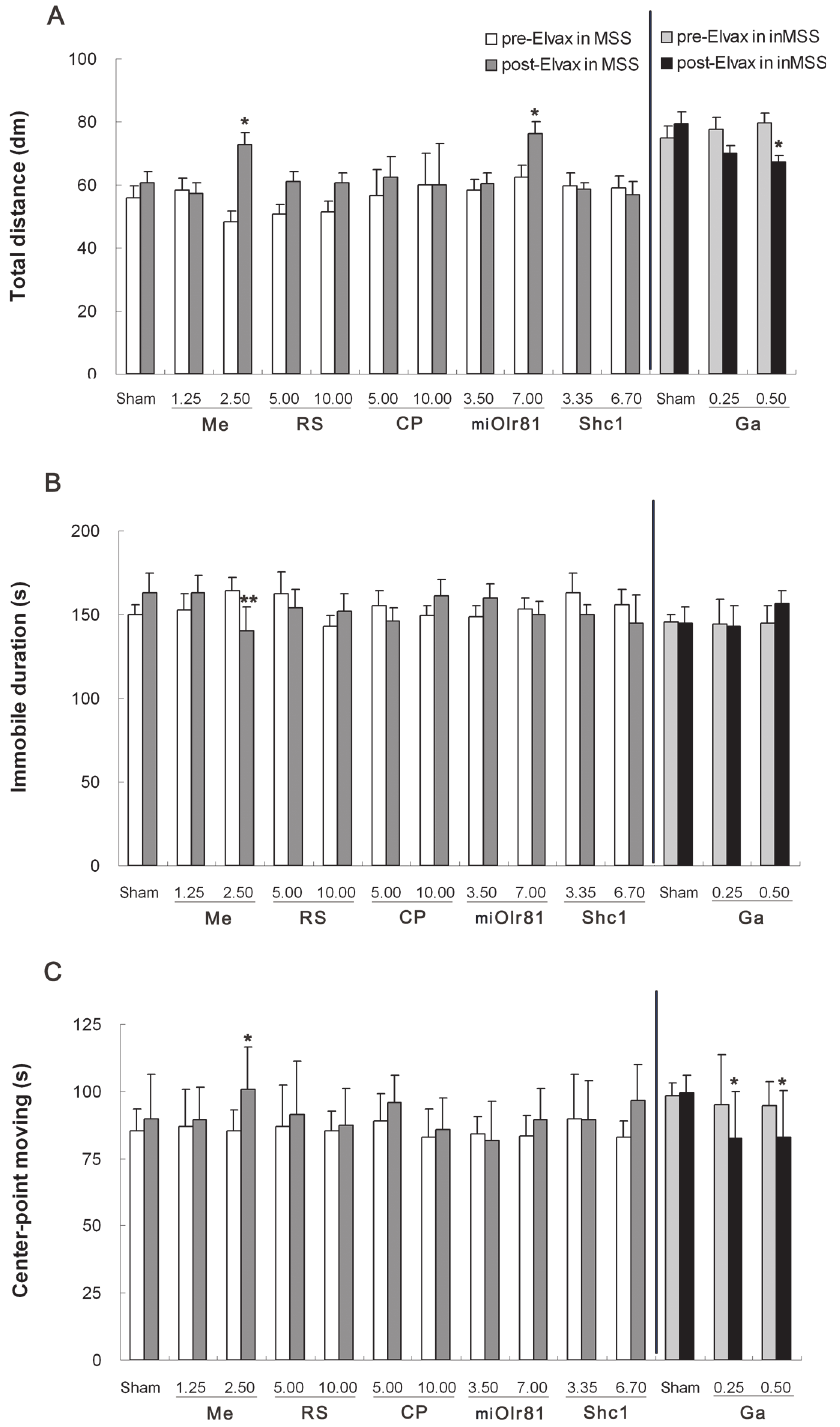
Fig 6. Effects of Elvax implantation over the CVN on spontaneous locomotion activity after rotation stimulation. (A) Total distance travelled; (B) Immobile duration; (C) Body center-point moving duration. The final concentration of mecamylamine (Me), RS39604 (RS, CP99994 (CP) and gabazine (Ga) and the final titer of pAd-shOlr81 (shOlr81) and pAd-Shc1 (Shc1) in Elvax, and the number of animals used in each treatment group are the same as those in Fig 5. All data presented are expressed as the means and the vertical bars represent SEM. * P < 0.05 compared with rotation-induced spontaneous locomotion activity response before the Elvax